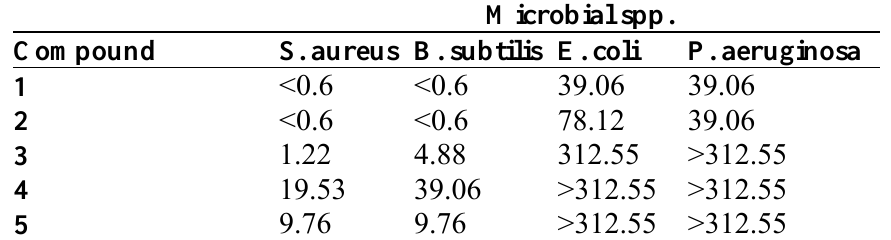
Table 3. Minimum inhibitory concentrations (MIC) for imidazolium salts 1 - 5 in μ